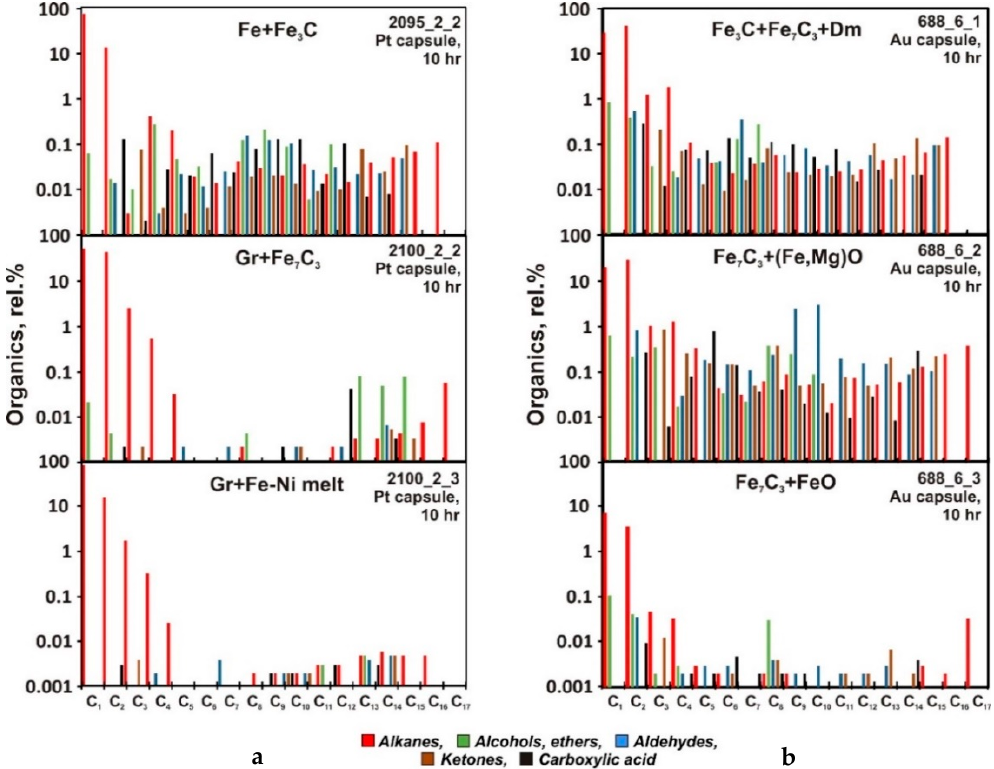
Figure 6. Speciation of minor organic components in quenched fluids obtained in the presence of metal phases at 1200 ◦ C. ( a ) Pt capsules; ( b ) Au capsules.